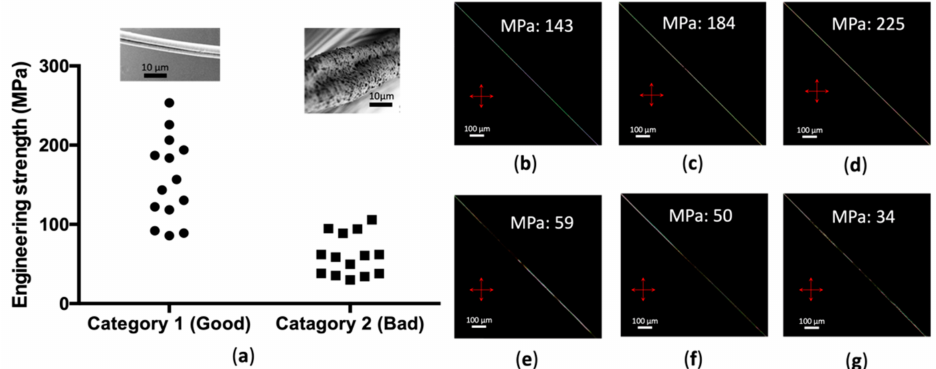
Figure 2. Manual sorting of fibers based on clearly visible different birefringent properties. ( a ) Plot of experimentally determined strength values for two categories of fibers. Insets: representative SEM images of fibers categorized as good and bad, respectively. ( b – d ) Representative POM images of fibers manually categorized as good. ( e – g ) Representative POM images of fibers manually categorized as bad. The orientation of the polarizers relative to the fiber is indicated by red double arrows. Insets: strength values of the fibers